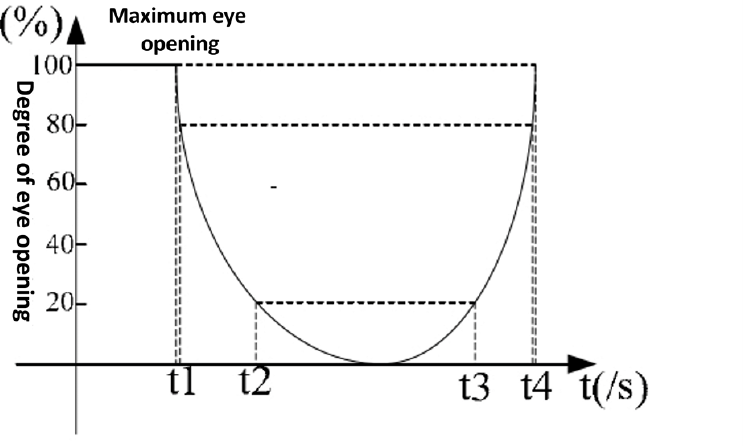
Figure 3. Principle diagram of PERCLOS